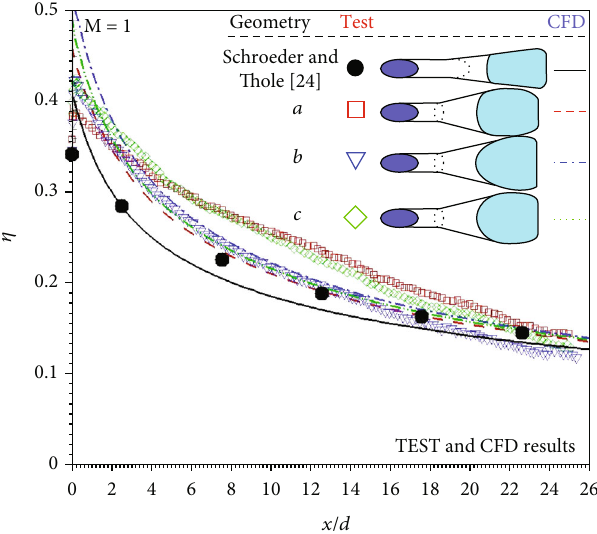
Figure 14: Laterally averaged fi lm e ff ectiveness for M = 1 .